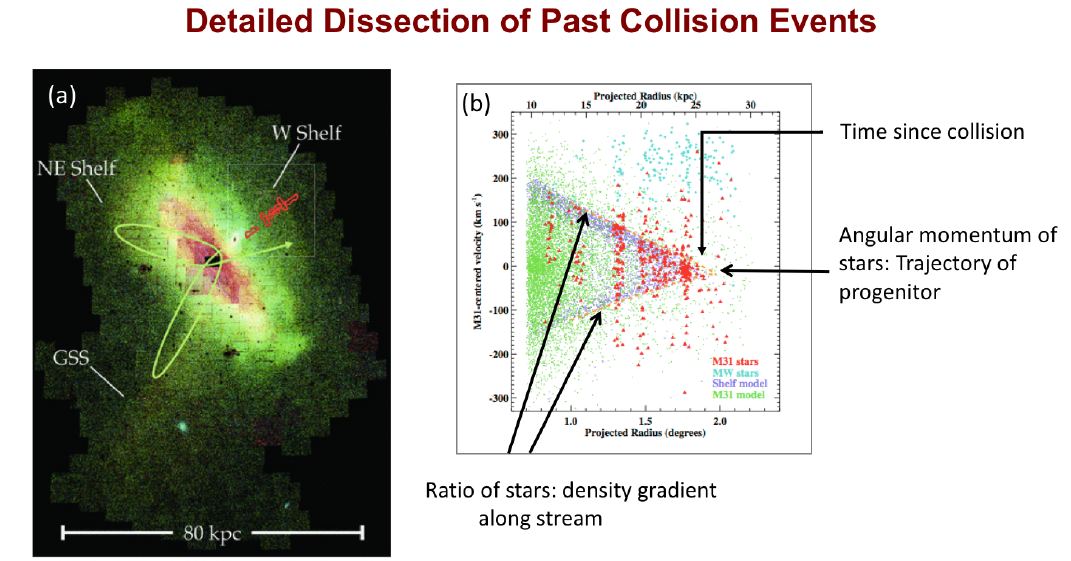
Figure 5. Shell systems, such as that created by the progenitor of the giant southern stream (GSS), provide exquisite observational constraints for modeling the orbit and properties of the dwarf satellite progenitor. Since confirmed as a shell system through the prediction and discovery of the southeast shelf [25,42], observations of the western shelf (shown here), in conjunction with previous observations of the GSS and southeast shelf, were used to determine the mass and disruption time of the progenitor, and to constrain the mass of M31 [44]. ( a ) Star count map of M31’s inner halo, derived from the INT survey of M31 (image created by M. Irwin [45]), with the location of the SPLASH spectroscopic slitmasks covering the western shelf region overlaid in red (Figure 1 of Fardal et al. [43]). The green curve shows the progenitor’s path in the model of Fardal et al. [43]. ( b ) M31-centric velocity ersus projected distance from M31’s center for observed M31 stars (large red points) and simulated particles (Figure 8 of Fardal et al. [43]). A quantitative comparison of data with the simulations can constrain the orbit and properties of the progenitor system: the ratio of stars in the upper and lower caustic of the shell feature constrains the density gradient along the stream, while the location of the tip of the feature in projected distance and velocity is sensitive to the time since the disruptive pericentric passage and the angular momentum of the stars,